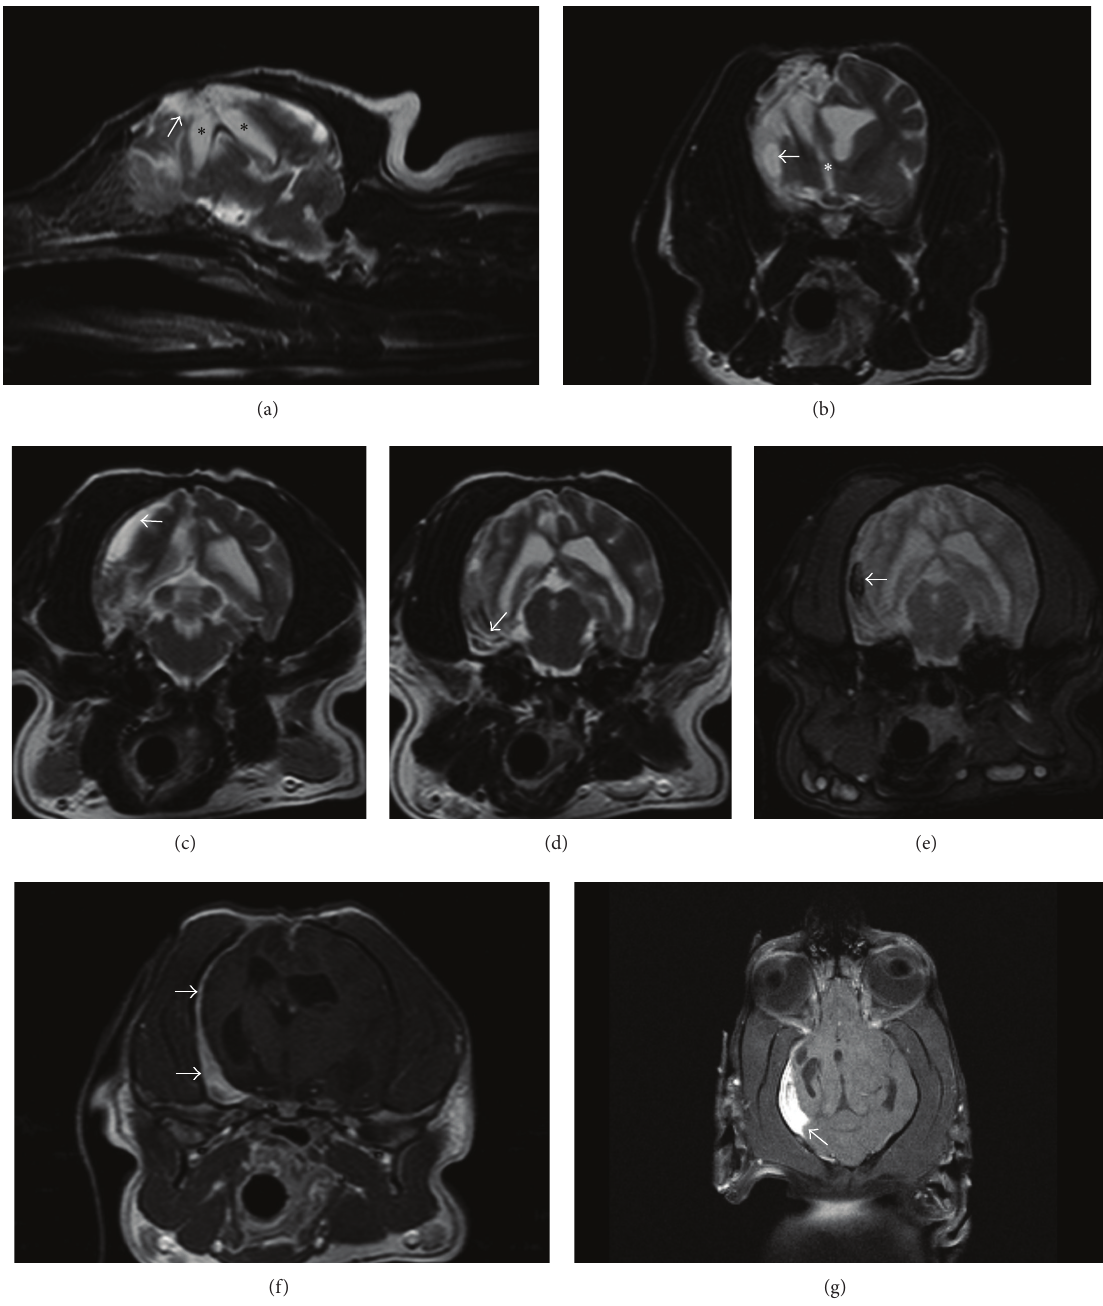
Figure 5: Postoperative MR images of the head. (a) T2-weighted right parasagittal image. The shape of the right lateral ventricle is abnormal (asterisks), and there is T2-hyperintense tissue in the area previously occupied by the abscess (arrow). (b) T2-weighted transverse image at the level of the rostral third ventricle (asterisk). There is parenchymal loss on the right side, with resulting midline shift toward the right. There are extraventricular fluid pockets within the parenchyma suppressed on T2-weighted FLAIR imaging (arrow). (c) T2-weighted transverse image at the level of the caudal colliculi. There is a peripheral rim of predominantly T2-hyperintense material along the right side of the cerebrum (arrow). (d) T2-weighted transverse image at the level of the midbrain. The peripheral rim is seen ventrally and has mixed T2 signal and a layered appearance (arrow). (e) T2 ∗ -weighted transverse image at the level of the midbrain. Signal voids within the rim (arrow) are consistent with hemorrhage. (f) Postcontrast T1-weighted transverse image at the level of the thalamus. The peripheral rim strongly and, in most areas, uniformly contrast enhanced (arrows). (g) Postcontrast T1-weighted dorsal image at the level of the mesencephalic aqueduct. Note the sharply defined margin of the peripheral contrast-enhancing material along the tentorium cerebelli